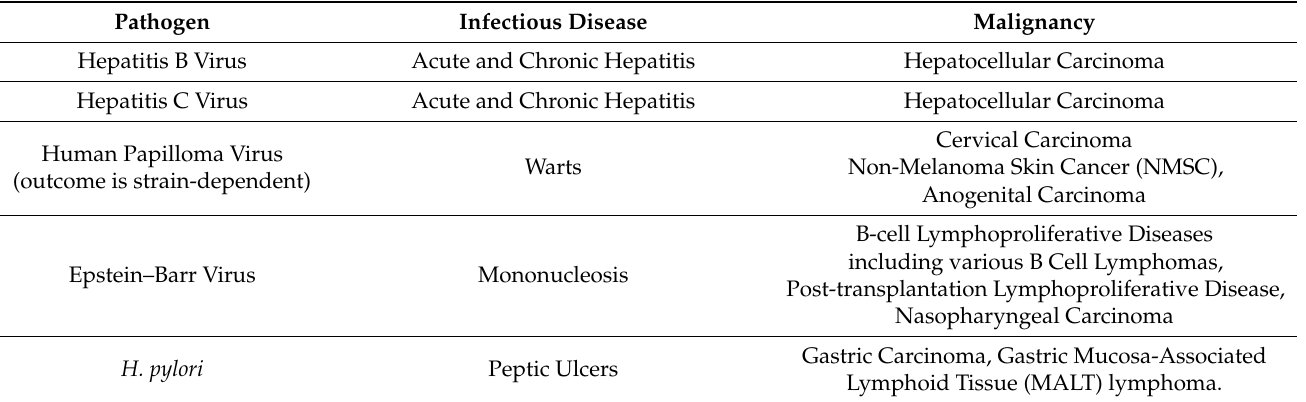
Table 1. Examples of Pathogen Etiologies of Infectious Diseases and